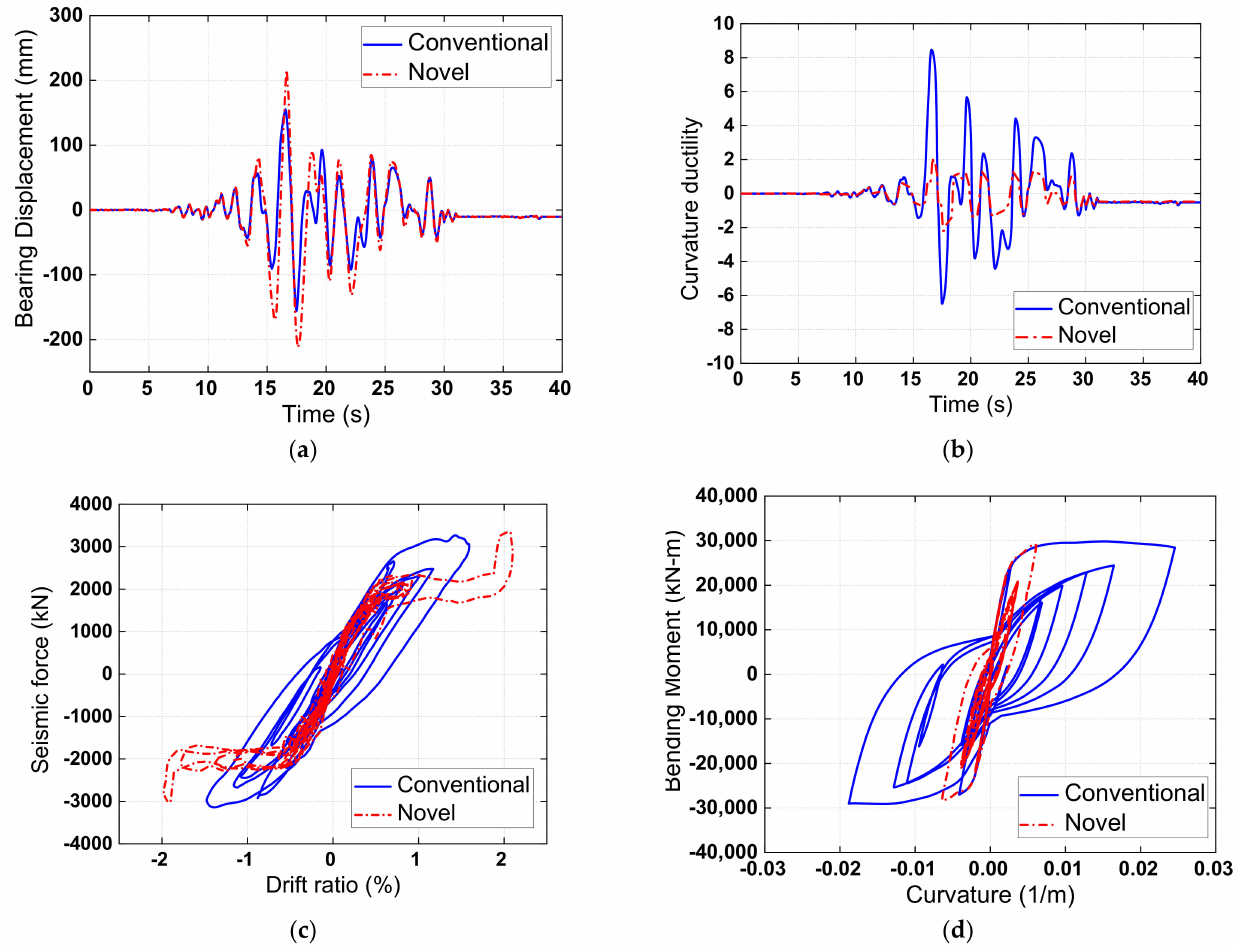
Figure 9. Seismic response of ( a ) bearing displacement, ( b ) curvature ductility, ( c ) seismic force versus drift ratio behavior, and ( d ) curvature versus bending moment